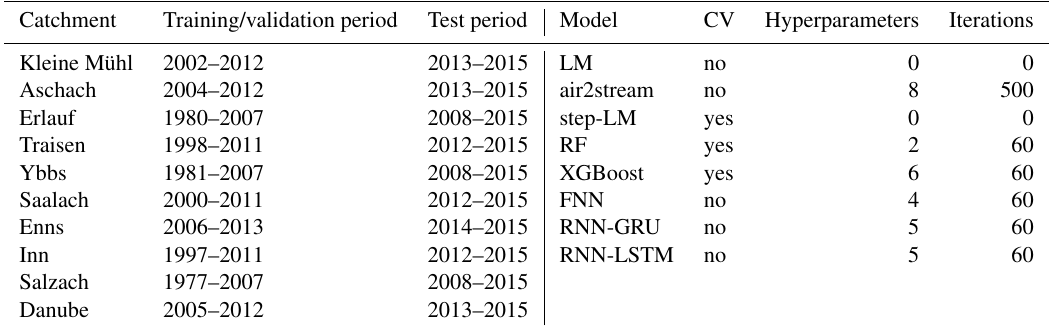
Table 3. Overview of the different modelling time periods and hyperparameter optimization details, including information about cross- validation (CV), the number of hyperparameters (Hyperparameters) and the number of iterations of the Bayesian hyperparameter optimiza- tion (Iterations). Test period Model CV